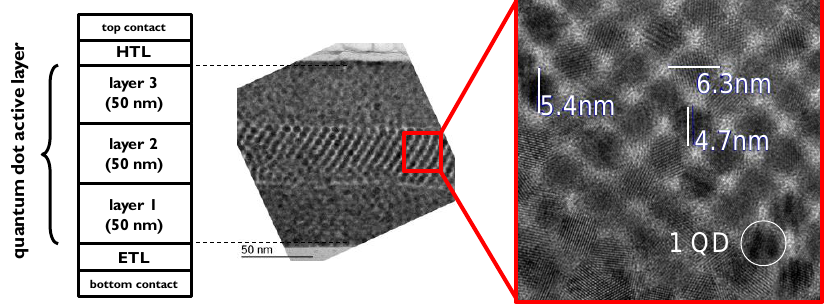
Figure 5. Cross-section ( left : schematic; right : Transmission Electron Micrograph) of a 3-layer active stack based on 5.5 nm PbS quantum dots.